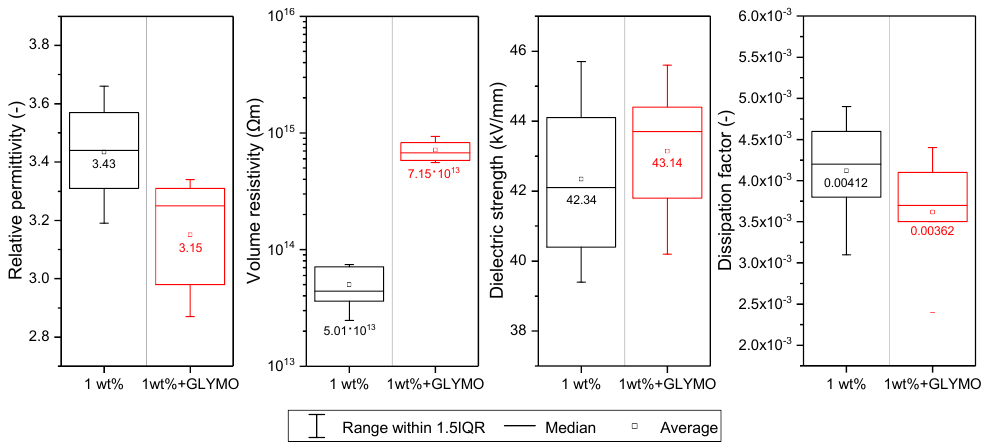
Figure 6. Changes of dielectric parameters of Epoxy/MgO and Epoxy/MgO+GLYMO composites (adapted from: